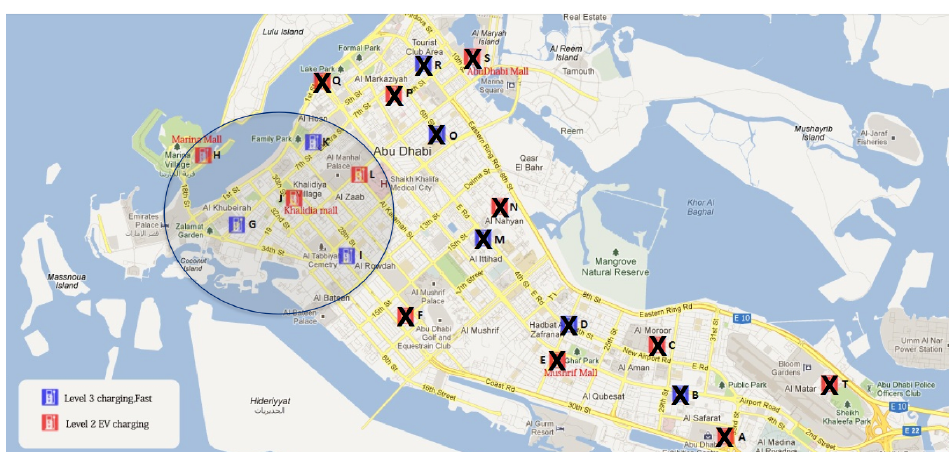
Figure 6. Limited Dense Mixed Charging System Design Map.